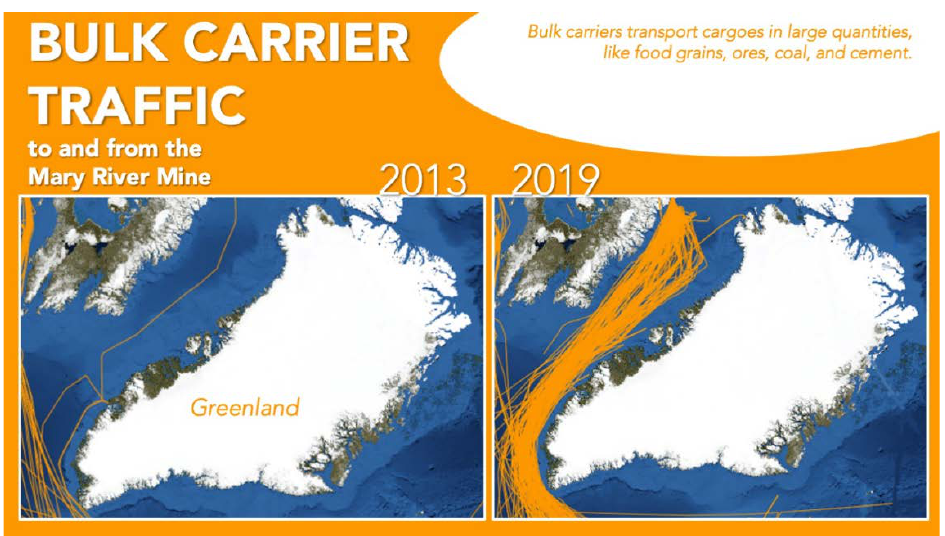
Figure 3. Bulk carrier traffic to and from the Mary River Mine. Courtesy of PAME—Arctic Shipping Status Report, available online: https://pame.is/projects/arctic-marine-shipping/arctic-ship- ping-status-reports/723-arctic-shipping-report-1-the-increase-in-arctic-shipping-2013–2019-pdf- version/file (accessed on 18 March 2021) [2].